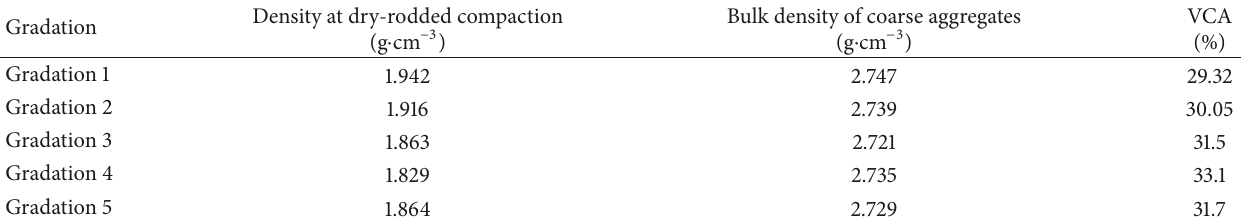
Table 6: The VCA of each gradation.